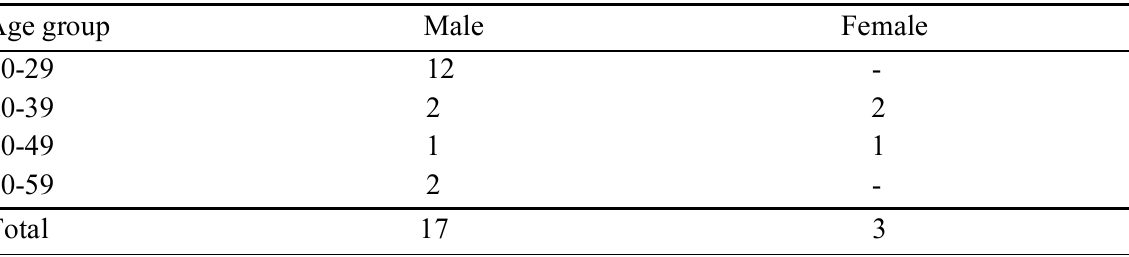
Table 1: Age and sex distribution (n=20)